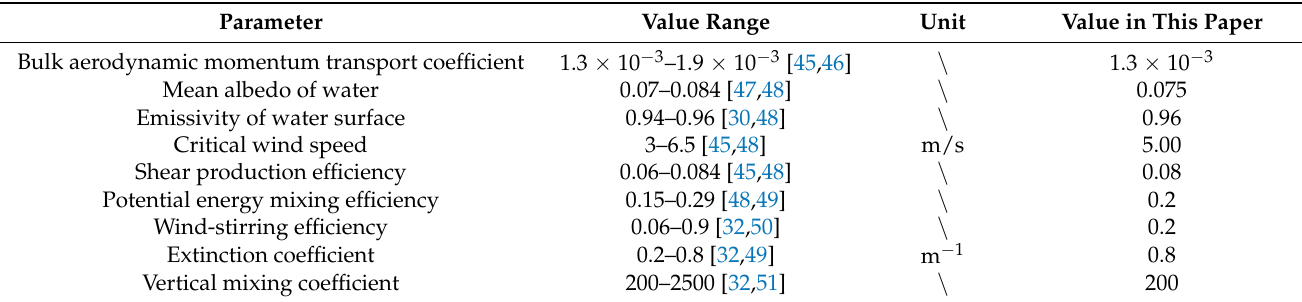
Table 3. Key parameters of